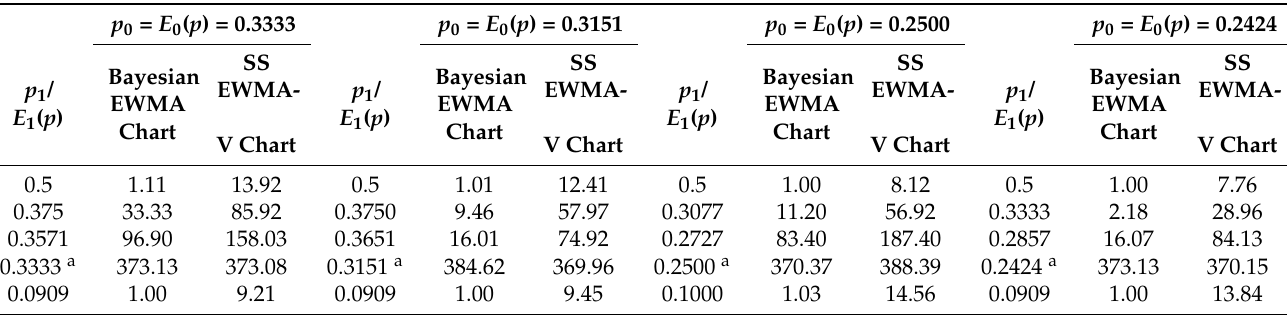
detect a shift of variance more quickly than the SS EWMA-V chart. Table 5. The out-of-control ARL comparison of the proposed Bayesian EWMA variance chart and the single sampling EWMA variance (SS EWMA-V)